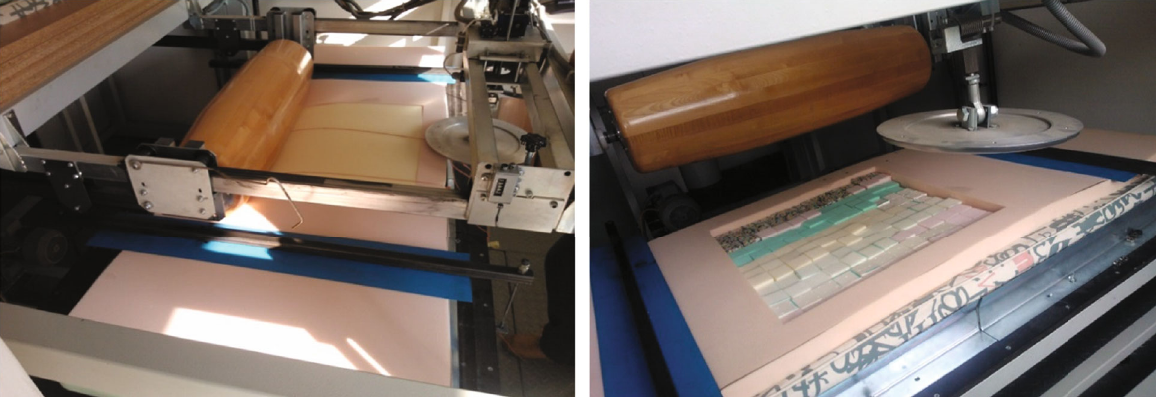
Figure 3: Images of the equipment used to simulate mechanical stress caused by repeated use.